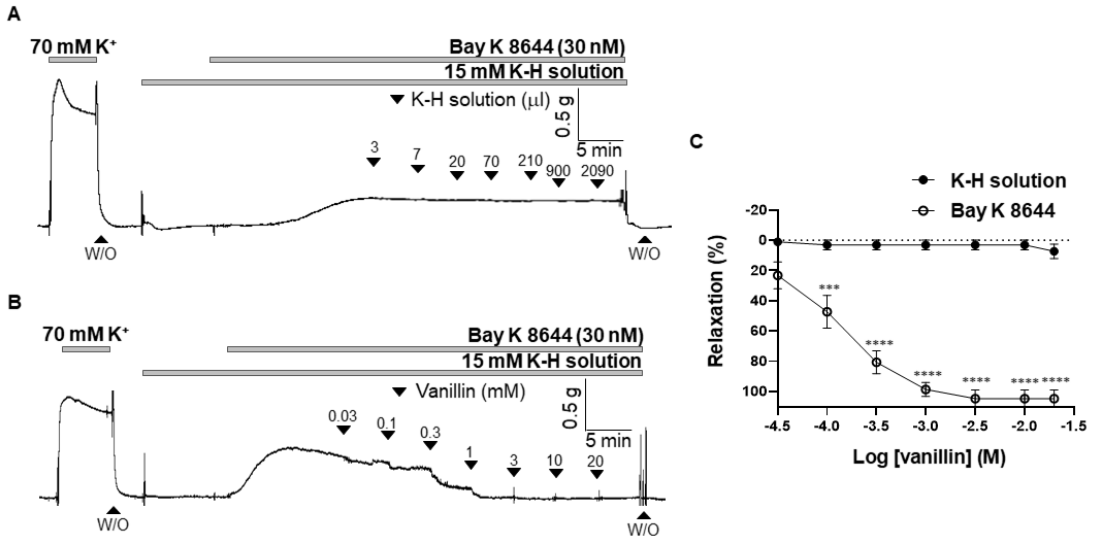
Figure 6. Vanillin reduced contraction induced by L-type voltage-gated calcium channel activation. Representative trace showing the effect of the vehicle (K-H solution, ( A )) and vanillin ( B ) in the BAY K 8644-induced contraction. Statistical analysis of relaxation induced by vanillin in the mesenteric arteries pre-constricted by BAY K 8644 ( C ). Mean ± SD ( n = 7). *** p < 0.001, **** p < 0.0001 (W/O: wash out).